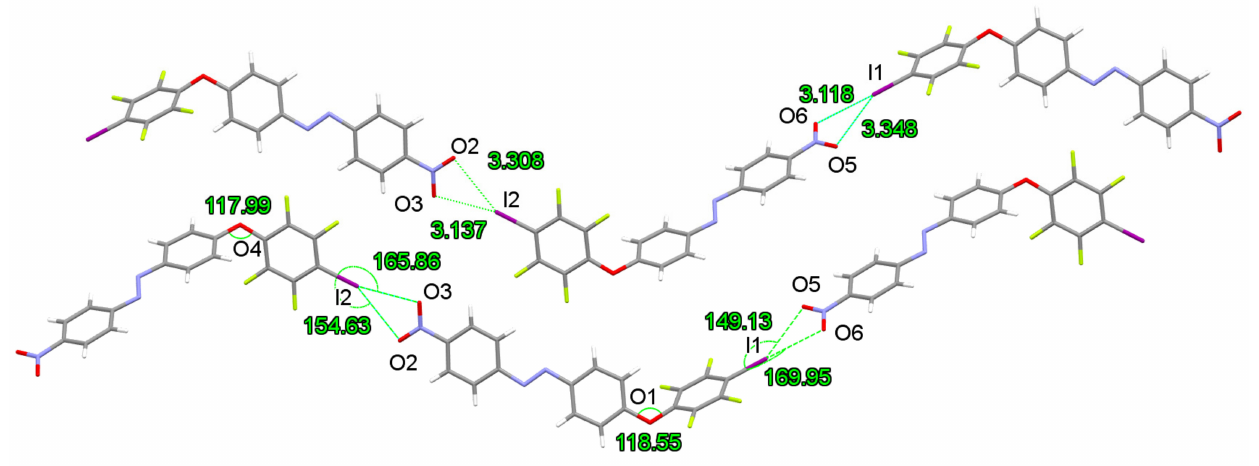
Figure 1. X-ray structure of I–azo–NO 2 developing undulating parallel chains due to two O ··· I halogen bonds. Colors are as follows: grey, C; blue, N; red, O; white, H; yellow, F; purple, I. O ··· I bond distances (Å) and C–I ··· O bond angles ( ◦ ).